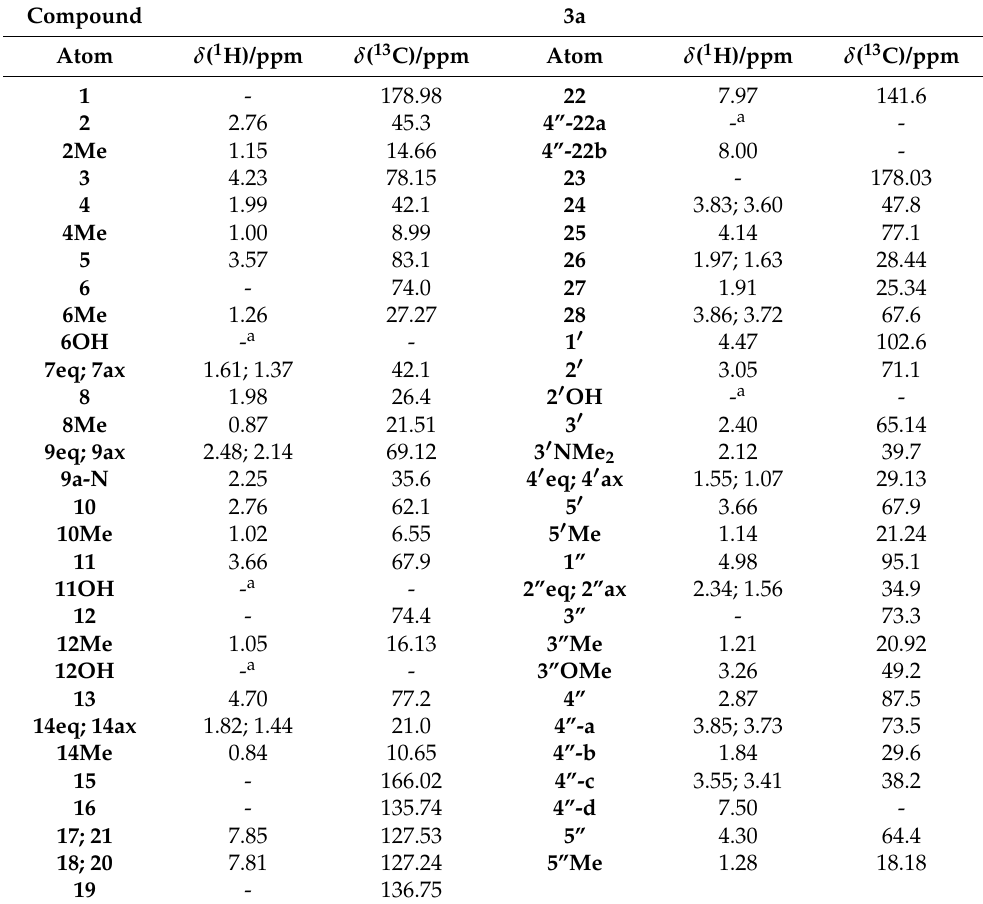
Table 1. 1 H and 13 C chemical shifs of 4”-tetrahydrofurfuryl macrozone 3a .